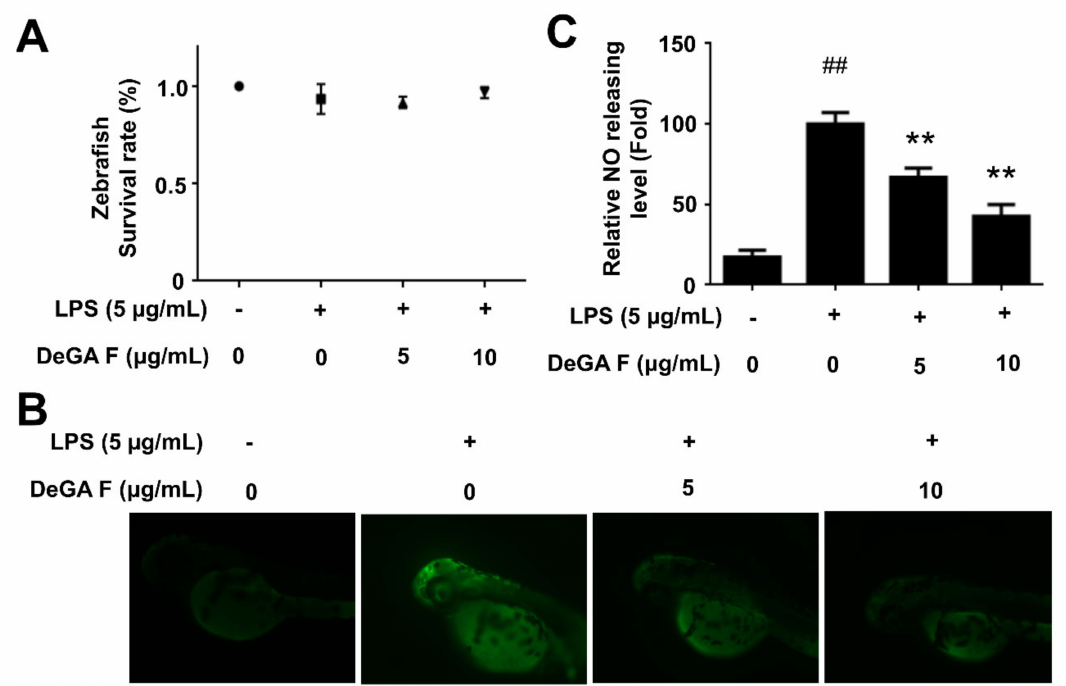
Figure 4. DeGA F suppressed NO production in LPS-triggered zebrafish model. Zebrafish embryos were pretreated with DeGA F for 1 h, and then stimulated with LPS for another 24 h. ( A ) Toxicity of DeGA F ( ≤ 100 µ g / mL) on zebrafish model. ( B ) The NO level was determined by staining fluorescent probe DAF-FM DA for 1 h. ( C ) The results were calculated by ImageJ software. # p < 0.05 and ## p < 0.01 compared with blank group ( n = 15). – and + represented the absence or presence of LPS (200 µ g / mL), respectively. * p < 0.05 and ** p < 0.01 compared with the LPS group ( n =